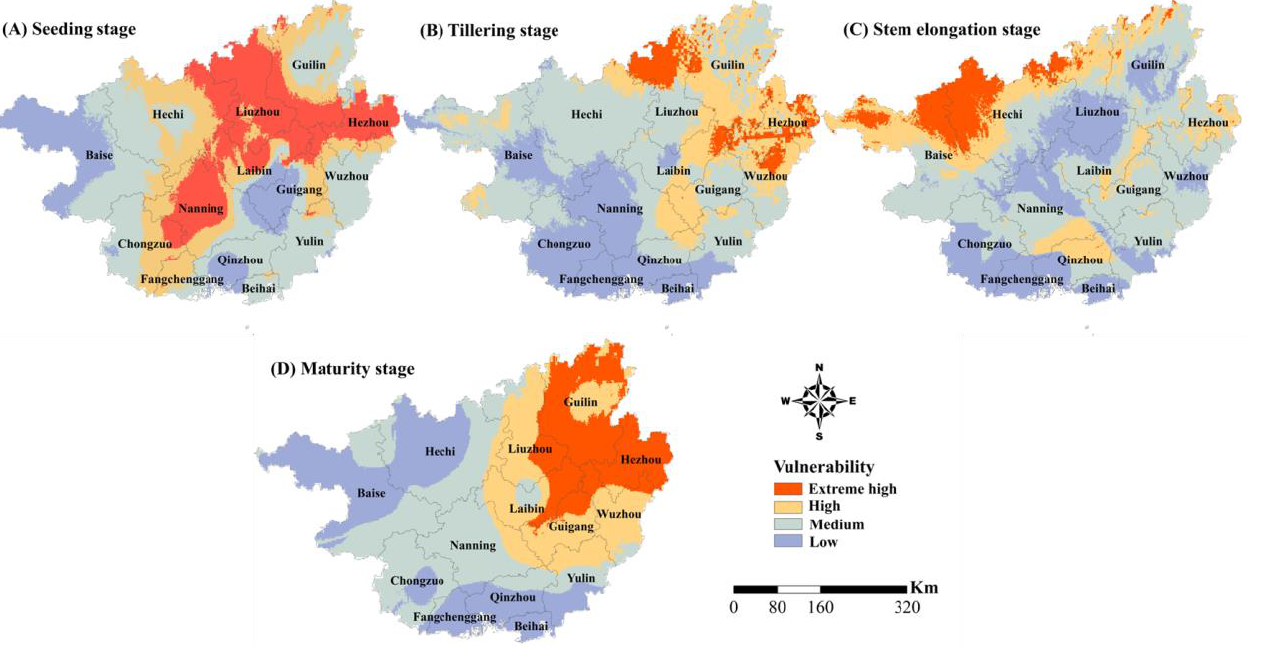
Figure 9. Spatial changes in the drought disaster vulnerability of sugarcane in the four growth stages in Guangxi: ( A – D ) represent the stages of seedling, tillering, stem elongation, and maturity, respec- tively.